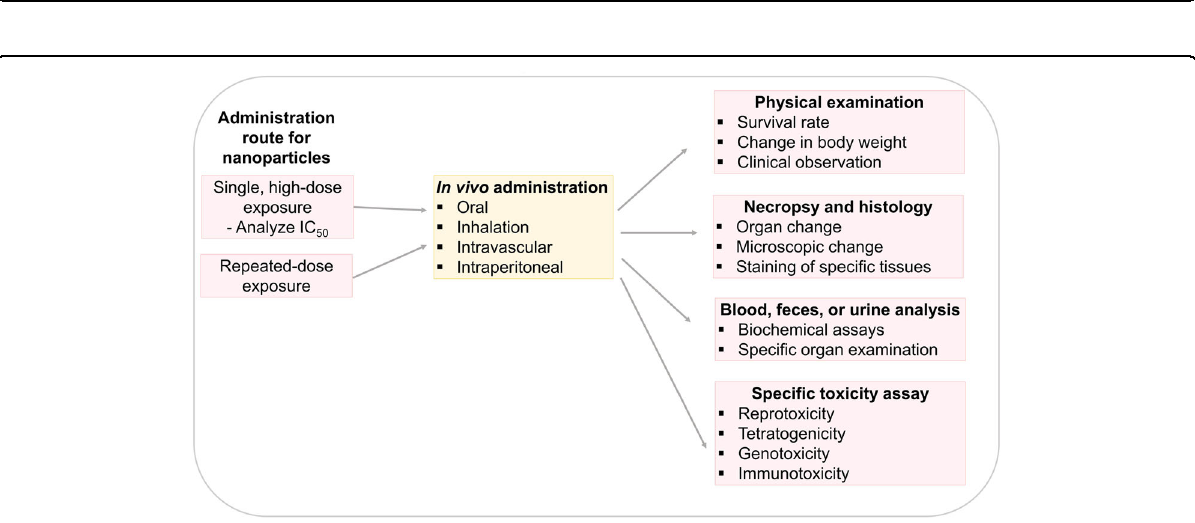
Fig. 18 Timeline of mesoporous silica nanoparticle (MSN) development in clinical trials. The timeline displays different types of MSN and the development in clinical trials. cRGDY cyclic arginyl-glycl[1]aspartic acid-tyrosine, PEG polyethylene glycol.